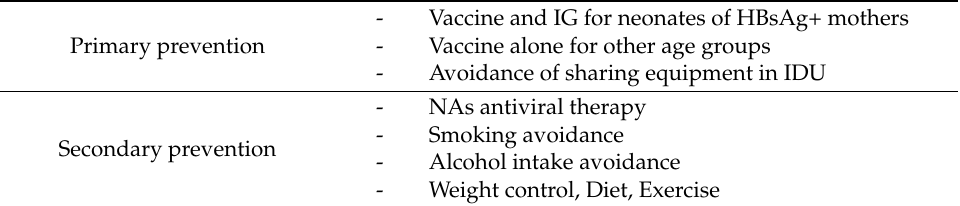
Table 3. Preventive measures for HBV-related HCC. IG: immunoglobulins; IDU: injecting drugs users; NAs: Nucleo(s)tides